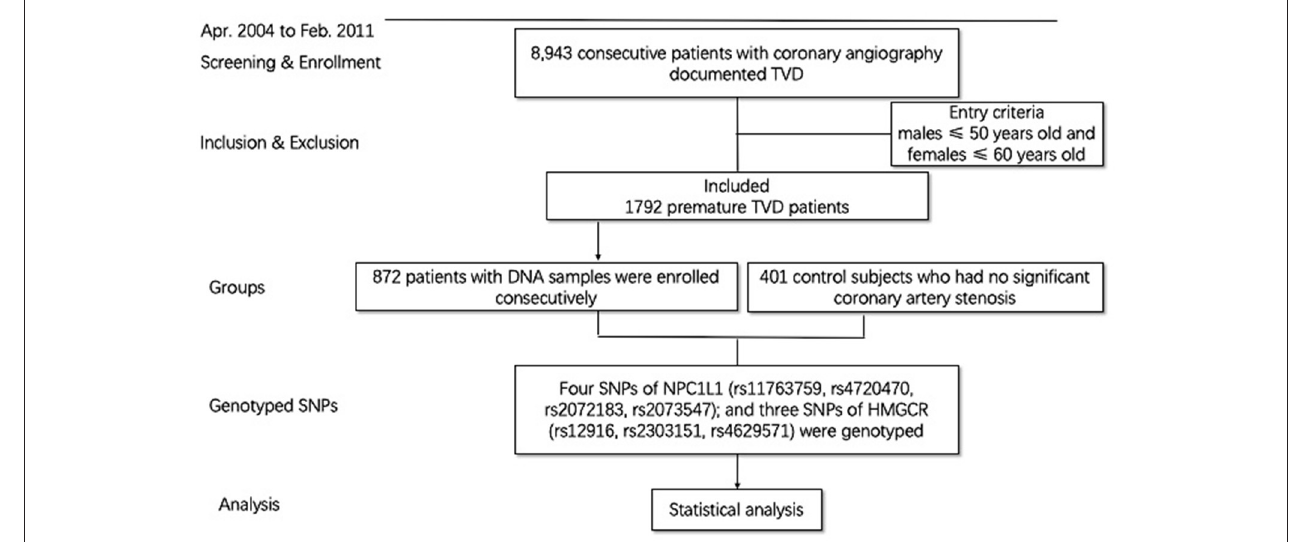
FIGURE 1 | Patient flow chart.